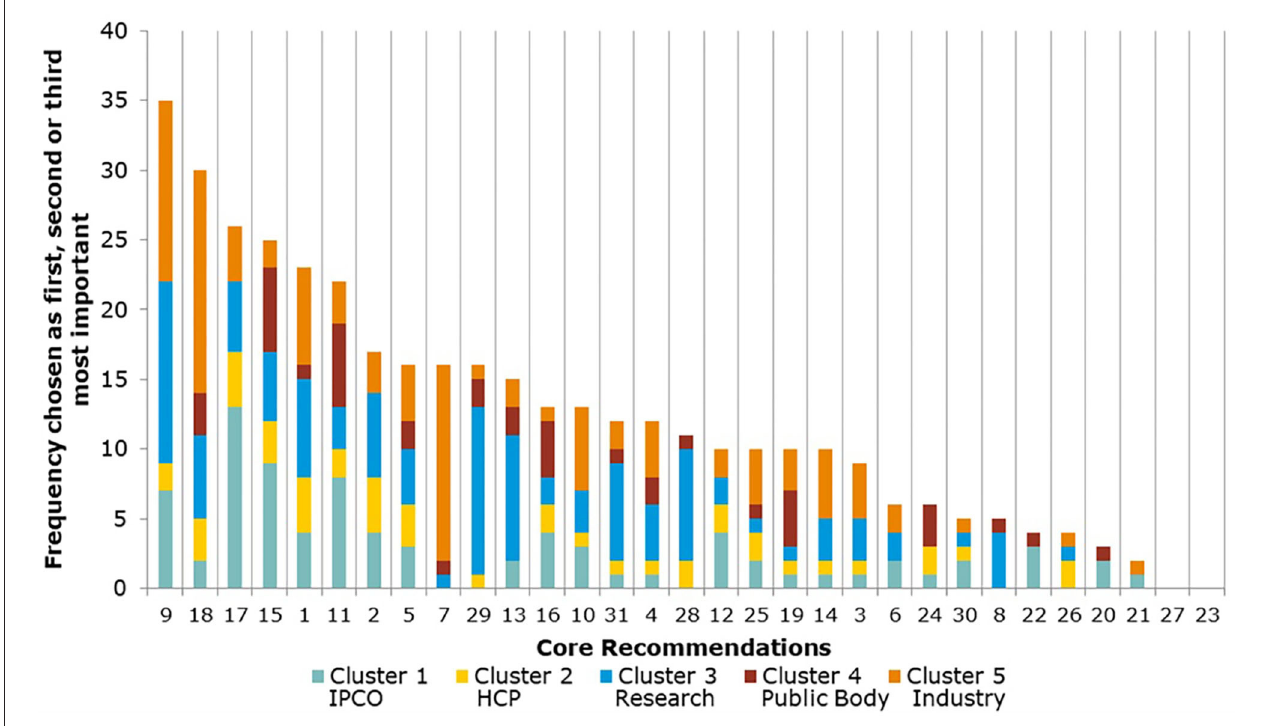
FIGURE 3 | Aggregate ranking of Core Recommendations (question 5, human).